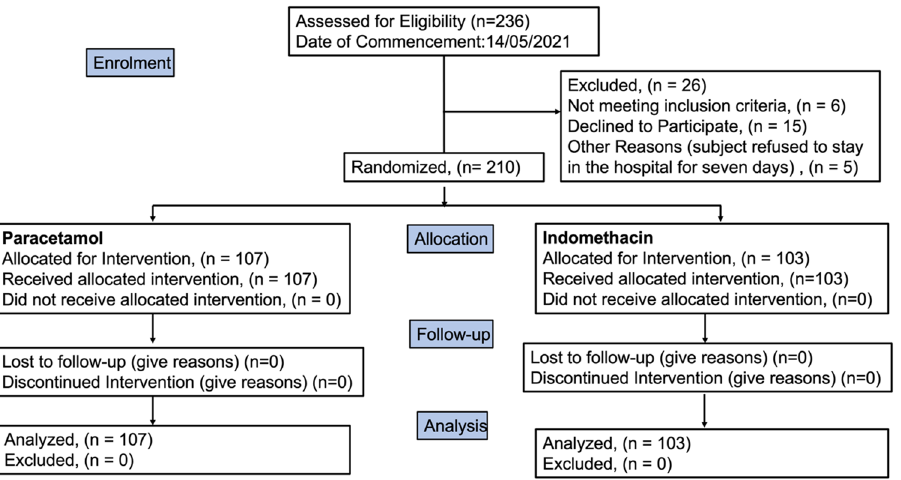
Figure 1. Flow diagram (created in Office 365: PowerPoint as an image and pasted).